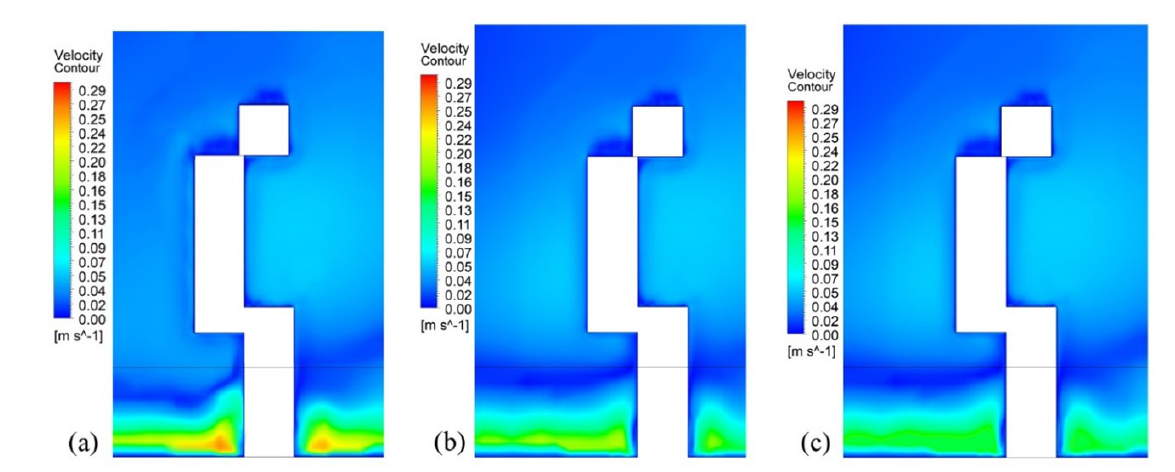
Figure 5. Simulated velocity contours around a human model at three distances from the radiant panel, namely distance of human model from panel, namely 20 cm (a), 35 cm (b), and 55 cm